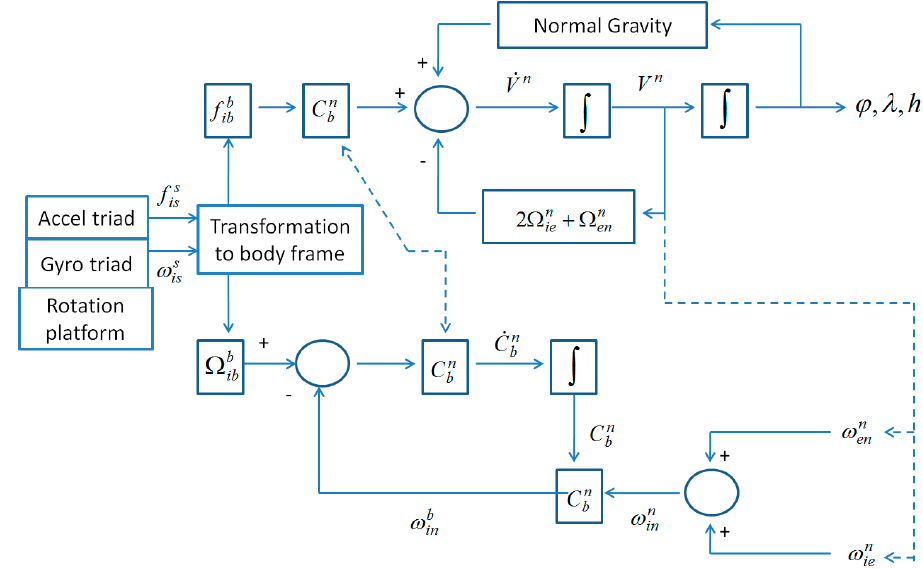
Figure 2. Flowchart of rotary INS mechanization.